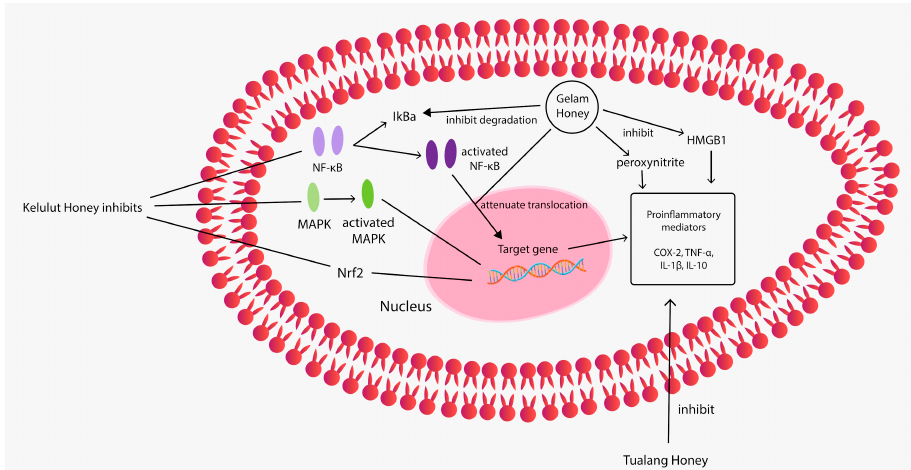
Figure 4. Anti-inflammatory mechanism of Tualang, Gelam and Kelulut honeys. TNF- α : tumor necrosis factor alpha; COX-2: cyclooxygenase-2; TNF- α : tumour necrosis factor alpha; IL-1 β : interleukin-1 beta; IL-10: interleukin 10; NF-kB: nuclear factor kappa B; I κ B α : NF-kappa-B inhibitor alpha; MAPK: mitogen-activated protein kinases; Nrf2: nuclear factor erythroid 2–related factor 2.